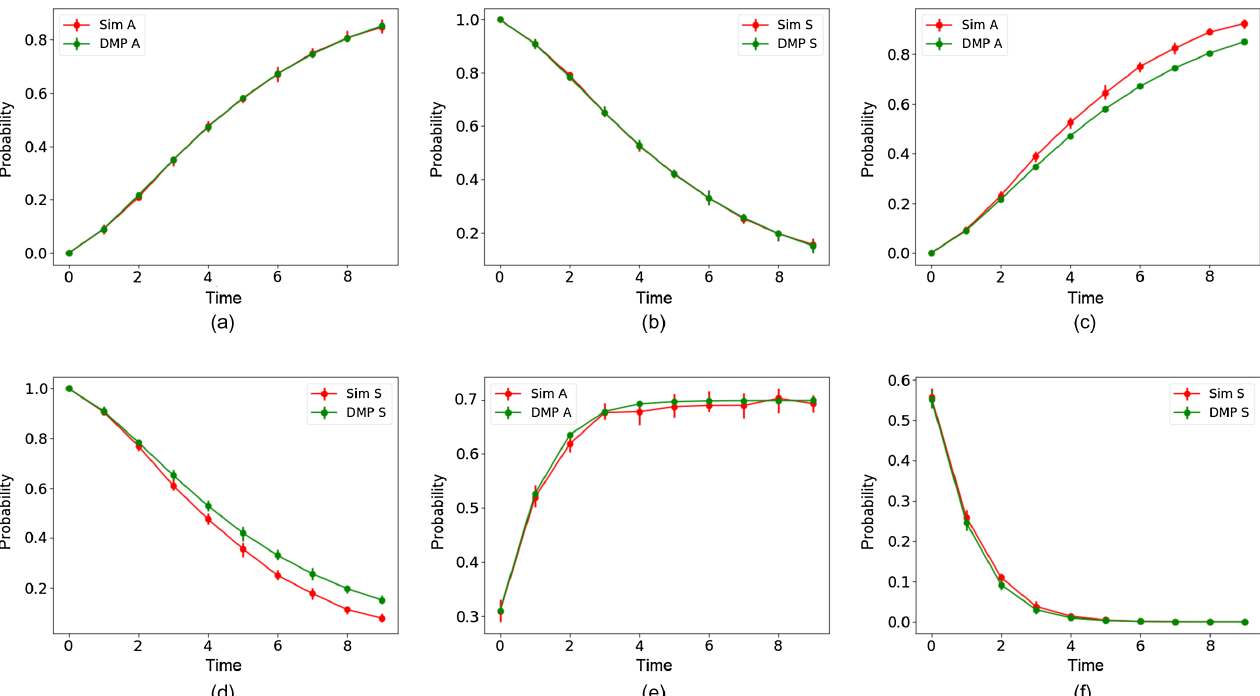
FIG. 2. Comparison of DMP-based results and Monte Carlo simulations for competitive processes. For each of the graphs, 10 5 samples have been used, and both mean values and error bars are shown, unless they are smaller than the symbol size. (a) Competitive process on a treelike network using the parameters α A ¼ 0 . 3 , α B ¼ 0 . 7 and observing P i ¼ 3 A ð t Þ . The seeds initializing the processes are placed in nodes 7 for process A and in nodes 2 for process B . (b) Same as in panel (a) but observing P i ¼ 3 S ð t Þ . (c) Comparing results from the DMP method and Monte Carlo simulation for the network with loops using the same parameters as in panel (a) and observing t Þ . (d) Same as panel (c) but observing P i ¼ 3 t Þ . For the Polbooks experiment, we observe (e) P i ¼ 0 t Þ and (f) P i ¼ 0 t Þ ; the P i ¼ 3 A ð S ð A ð S ð parameters used are α A ¼ 0 . 2 and α B ¼ 0 . 2 , and the seeds initializing the processes are placed in nodes 1 and 2 for process A and in nodes 4 and 37 for process B